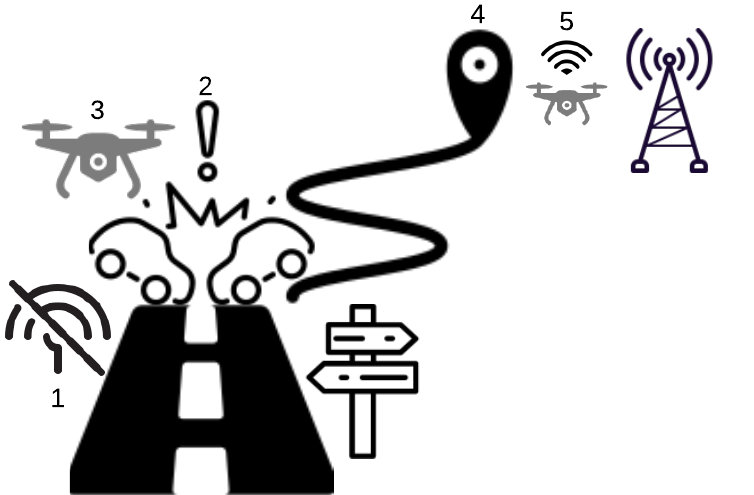
Figure 1. The UAV conveys emergency messages and sends them to the closest available network access